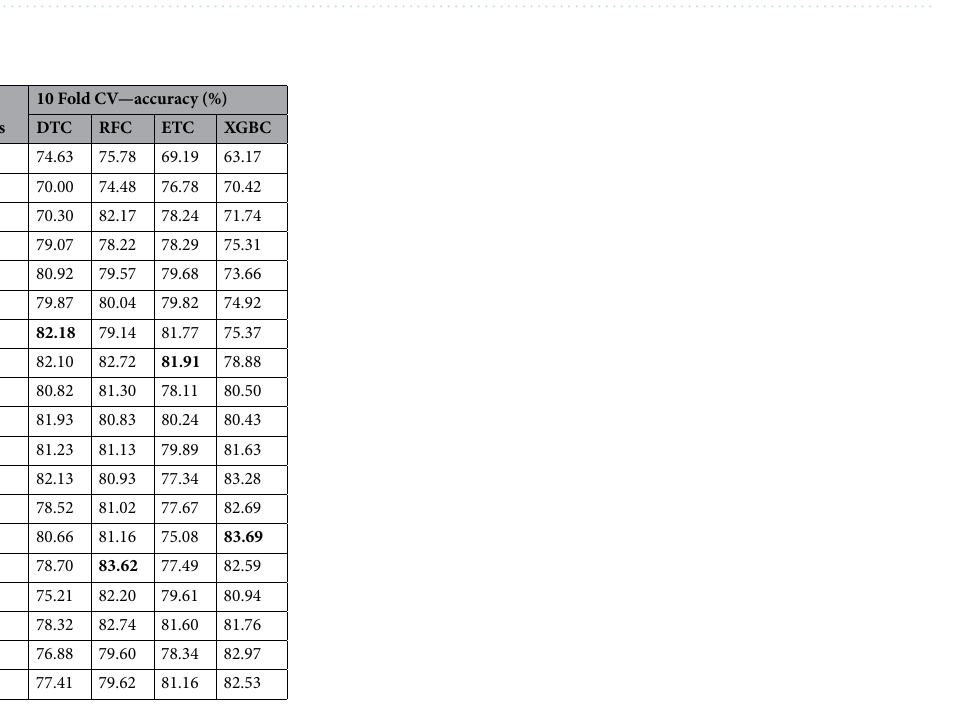
Table 5. Highly interacting and hydrogen bond generating amino acid residues of CRY1 with molecules.